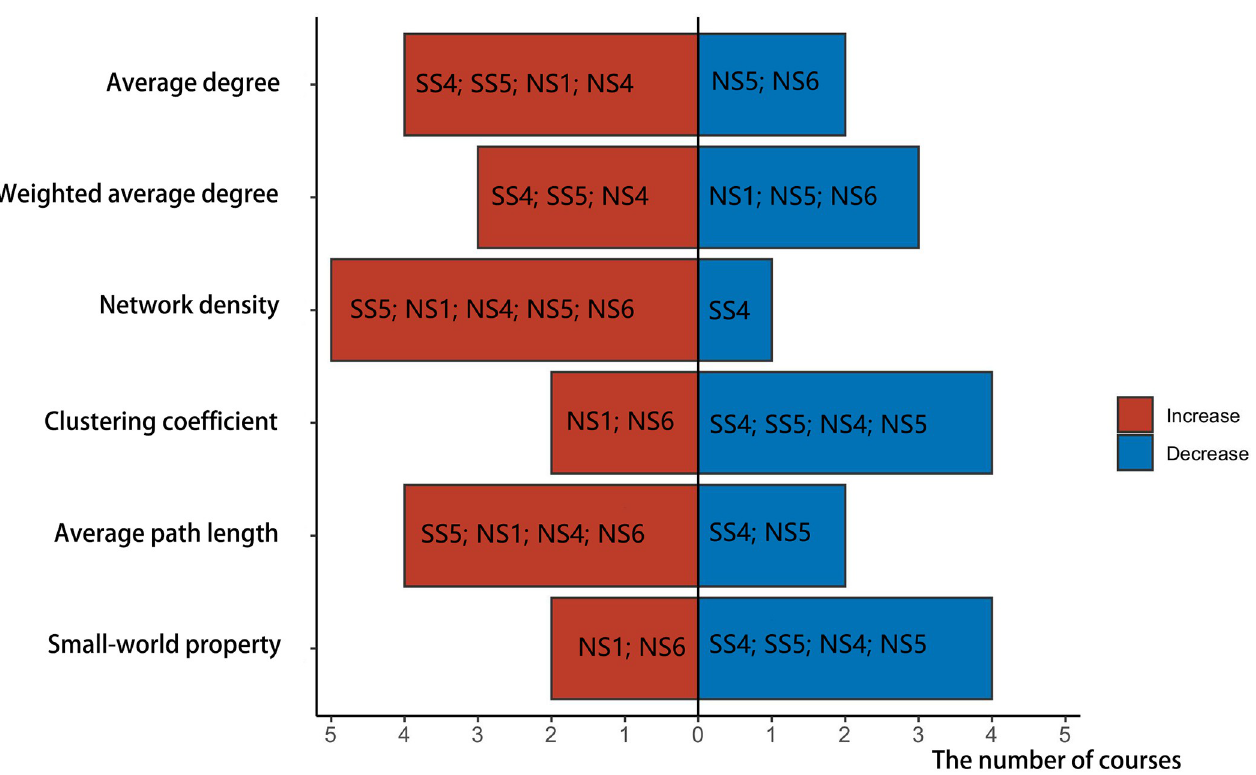
Fig 6. Changes in indicators of courses with no change in interaction scale from the COVID-19 outbreak until after the